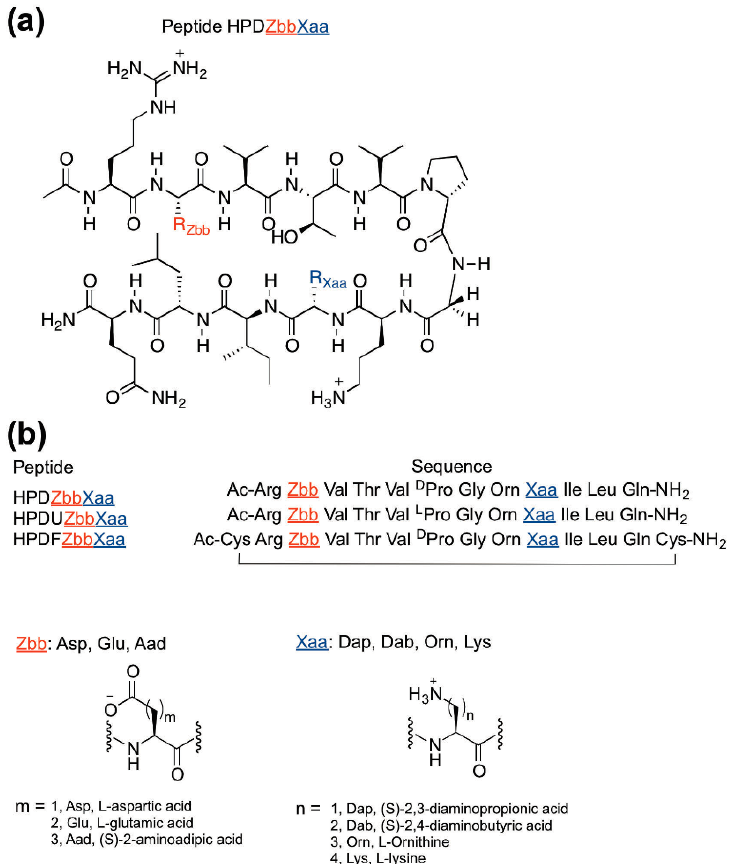
Figure 1. Design of peptides to study the effects of charged amino acid side-chain length on diagonal cross-strand ion-pairing interactions: ( a ) the chemical structure of the experimental HPDZbbXaa peptides; ( b ) the sequences of the experimental HPDZbbXaa peptides, the fully unfolded reference HPDUZbbXaa peptides, and the fully folded reference HPDFZbbXaa peptides.